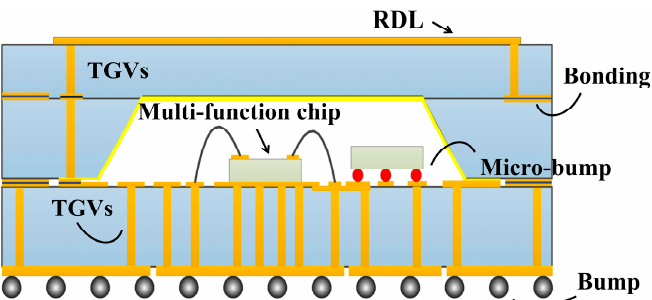
Figure 1. Typical vertical interconnections in glass packaging technologies.